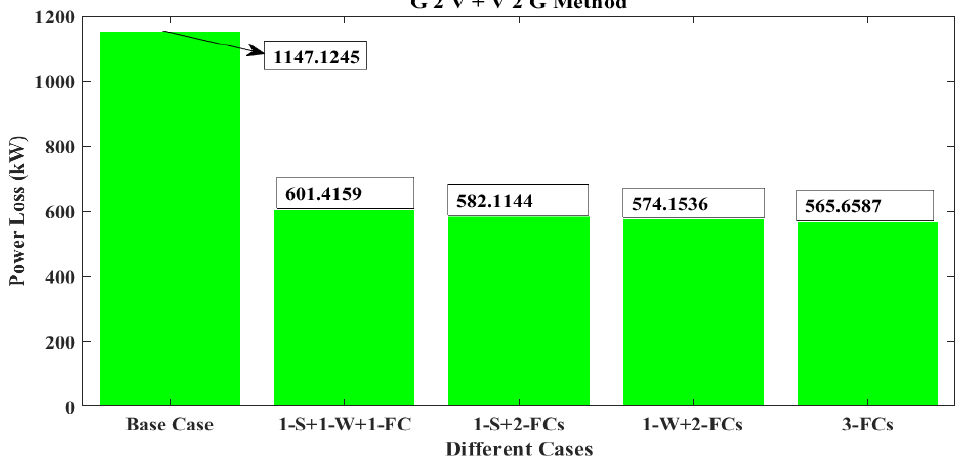
Figure 21. G2V + V2G P Loss with Different Cases.